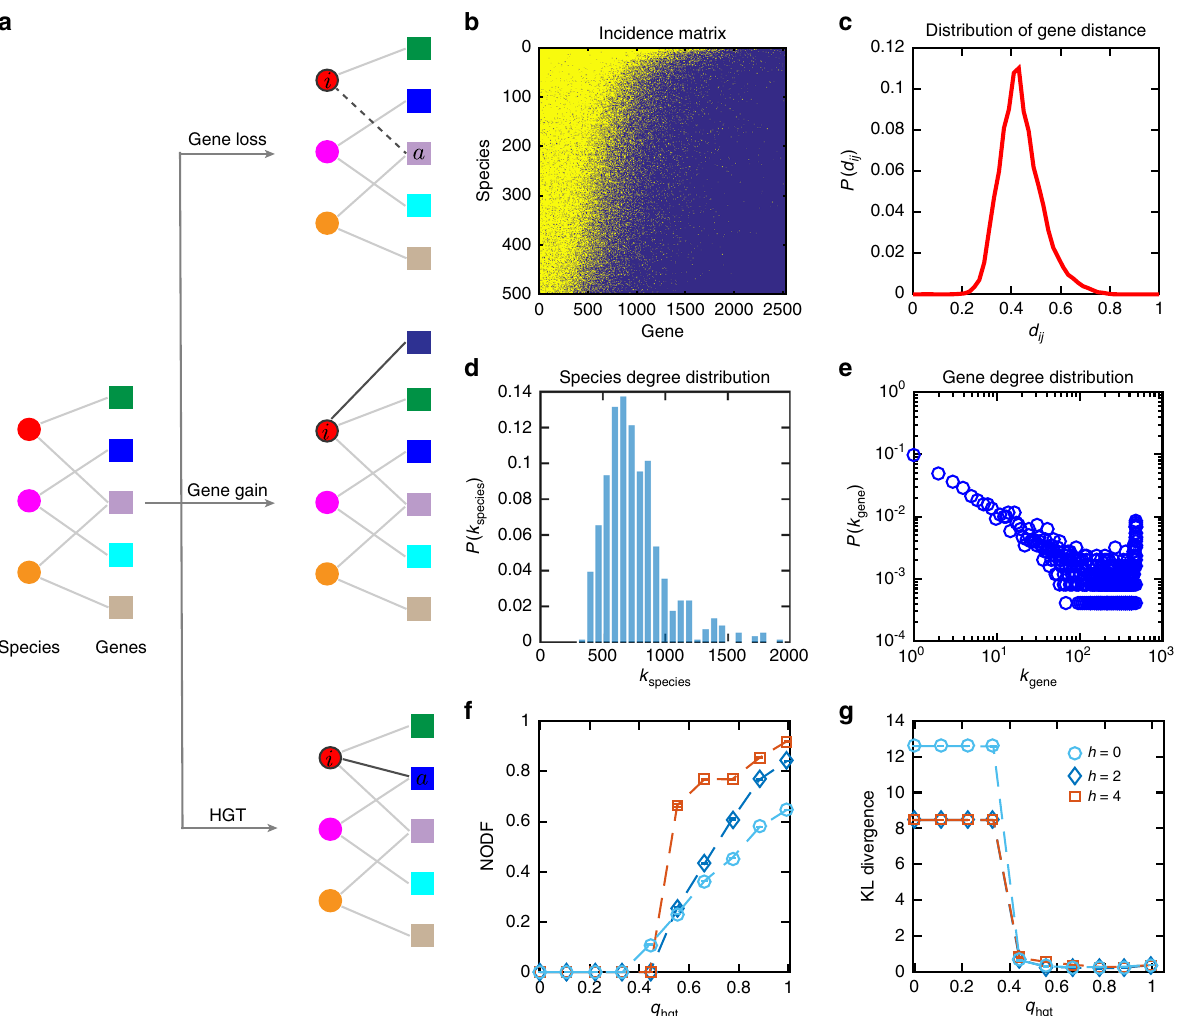
will be updated based i